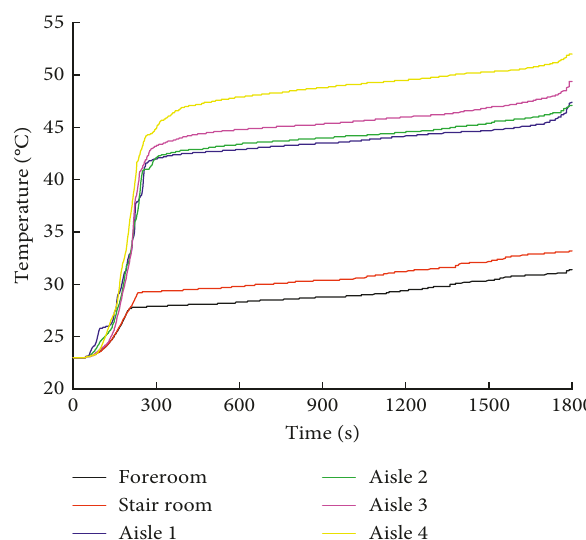
Figure 12: Temperature vs. time outside the room of fire scenario D10.